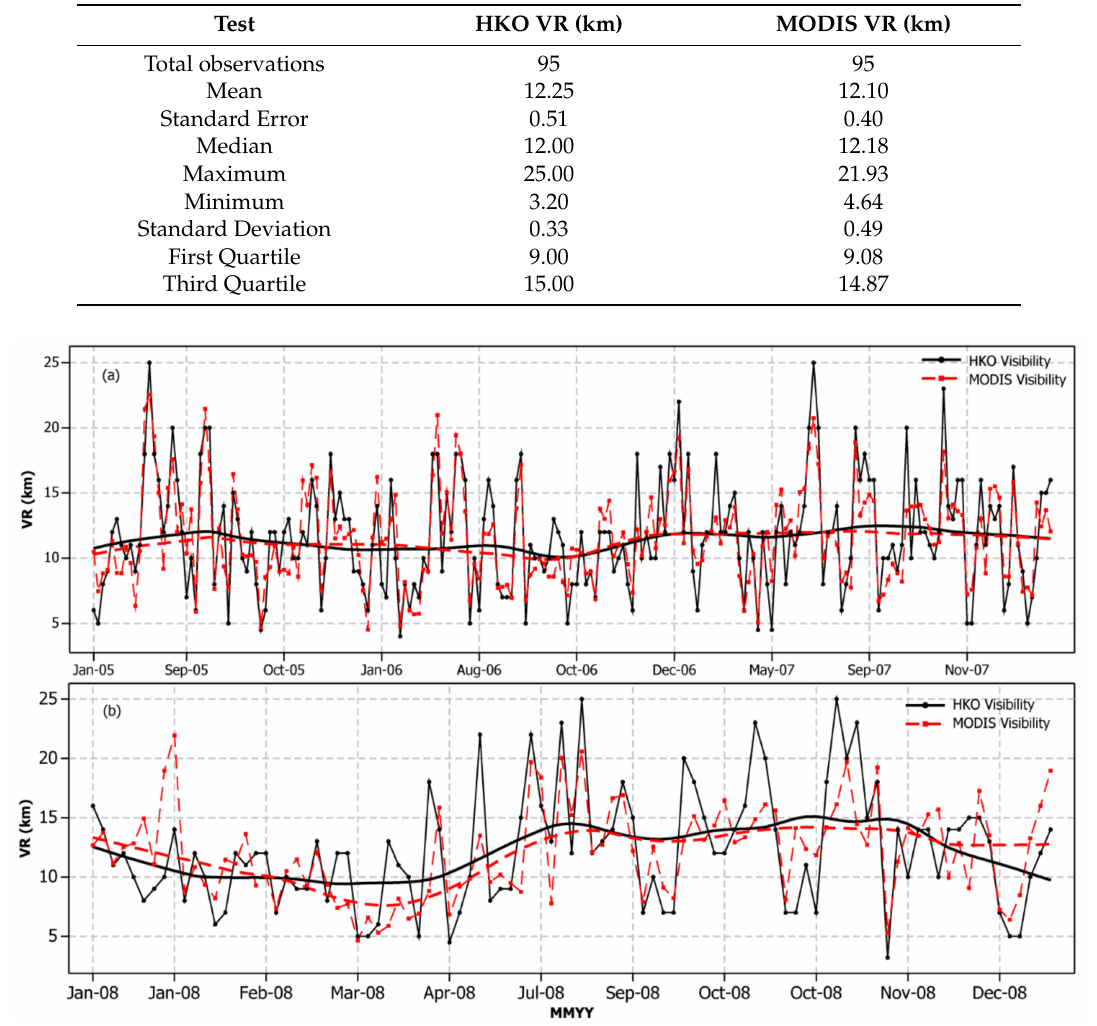
Table 4. Summary statistics for the real-time (HKO VR) and simulated (MODIS VR) VR at HKO for the year 2008.